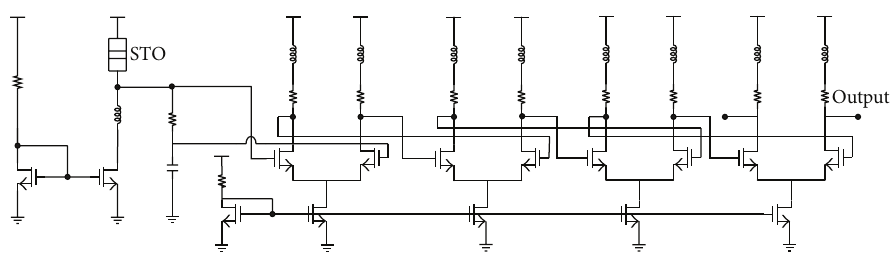
Figure 6: Circuit schematic of the current mirror circuit with a 4-stage common source